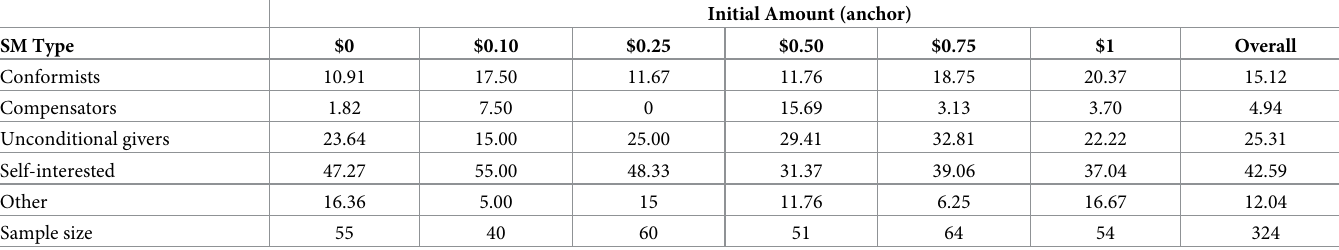
Table 4. Percentage distribution of SM types by